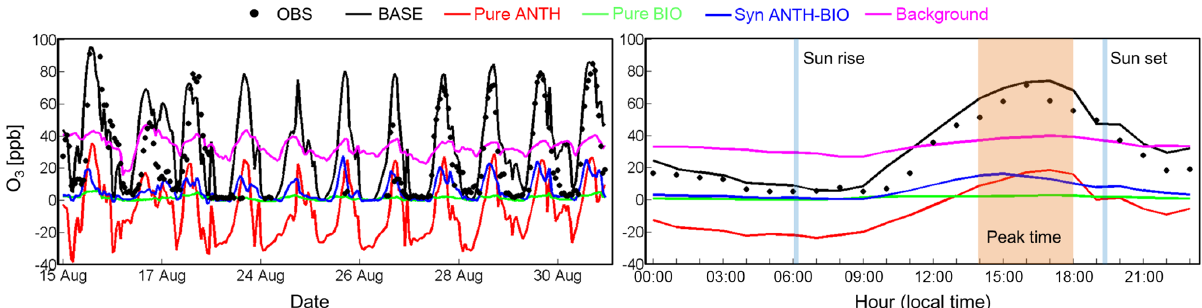
Figure 7. Temporal patterns of the simulated O 3 concentrations and the tested contributing components during the period from 15 to 30 Au-